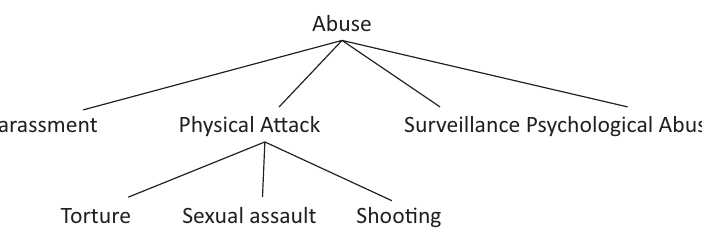
Figure 3. Simple partial ontology showing the relationship between (a selected set of) different kinds of